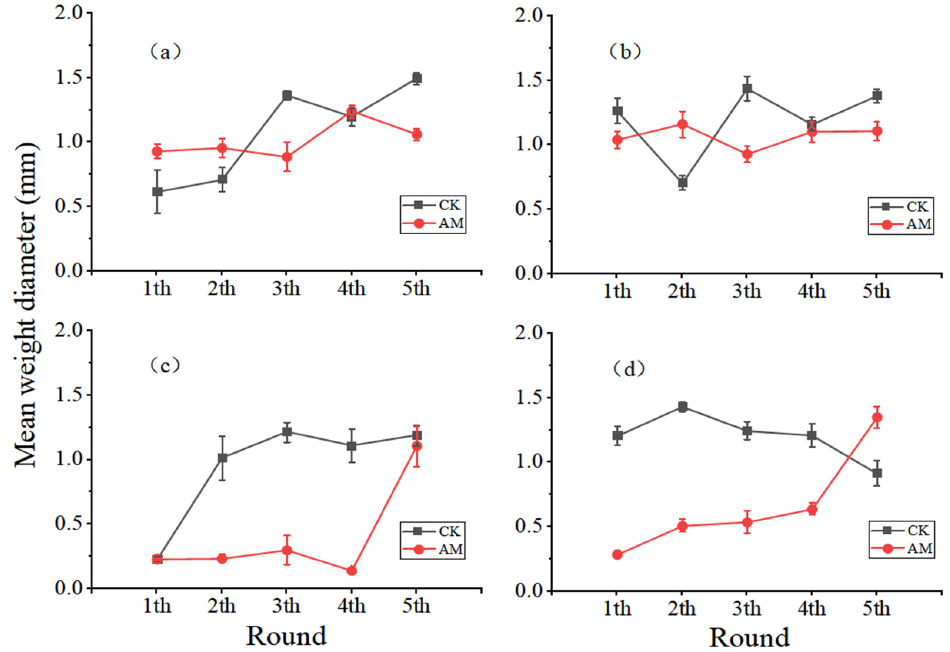
Figure 6. Variation in sediment MWD in different soil troughs under simulated scouring in ( a ) Cynodon dactylon , ( b ) Lotus corniculatus , ( c ) Zoysia japonica , and ( d ) Astragalus sinicus . Error bars represent ± standard errors.